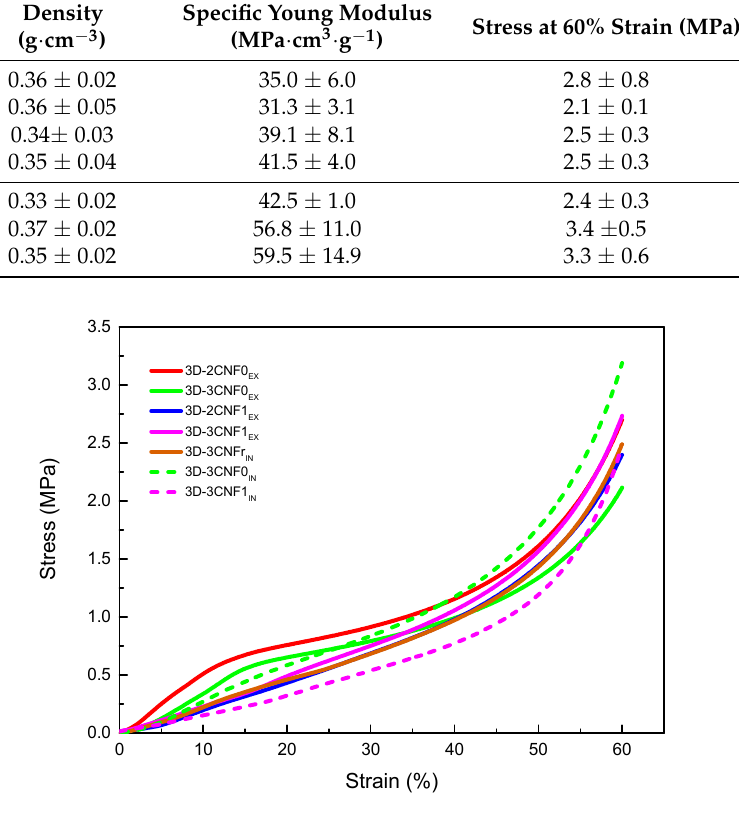
Figure 8. Stress/Strain curves from compression tests for WBPU/CNF 3D-printed parts.